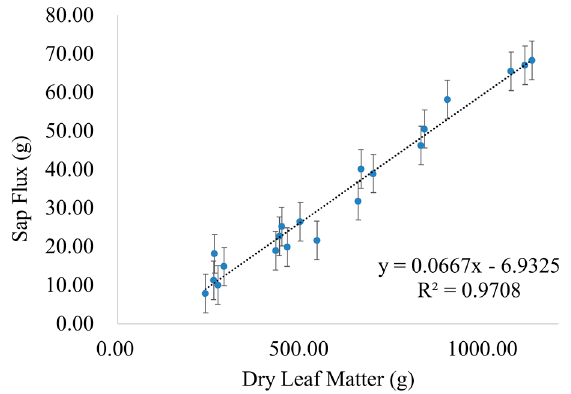
Figure 7. The relationship between sap flux and dry leaf mass.